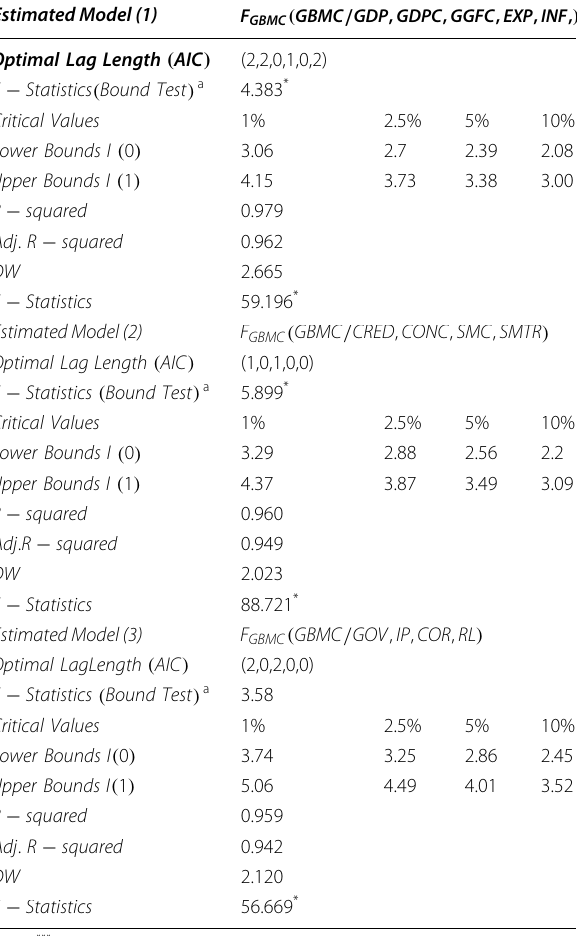
Table 4 Results of the Bounds test of